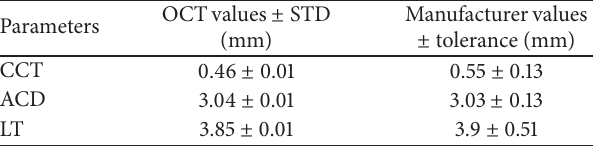
Table 3: OCT measurement of model